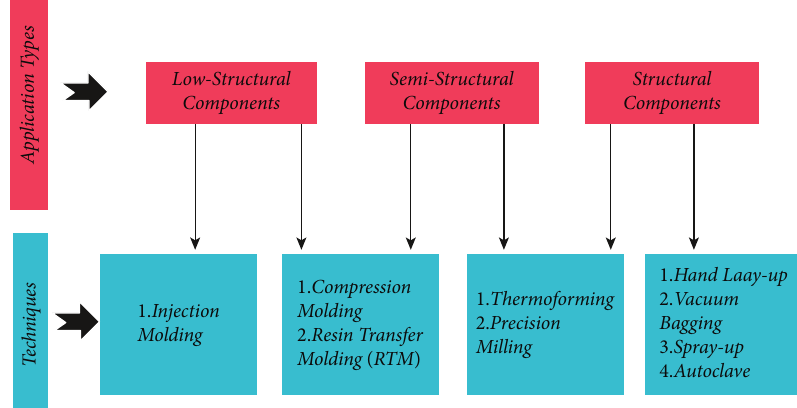
Figure 3: Application of different manufacturing techniques in fabrication of structural components.